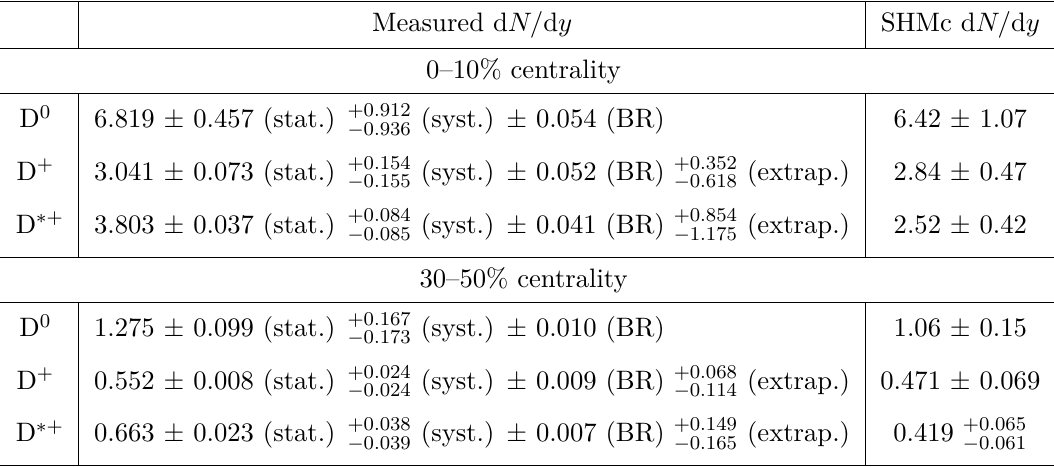
Table 4 . Measured p T -integrated yields of prompt D 0 , D + , and D ∗ + in | y | < 0.5 in the 0–10%